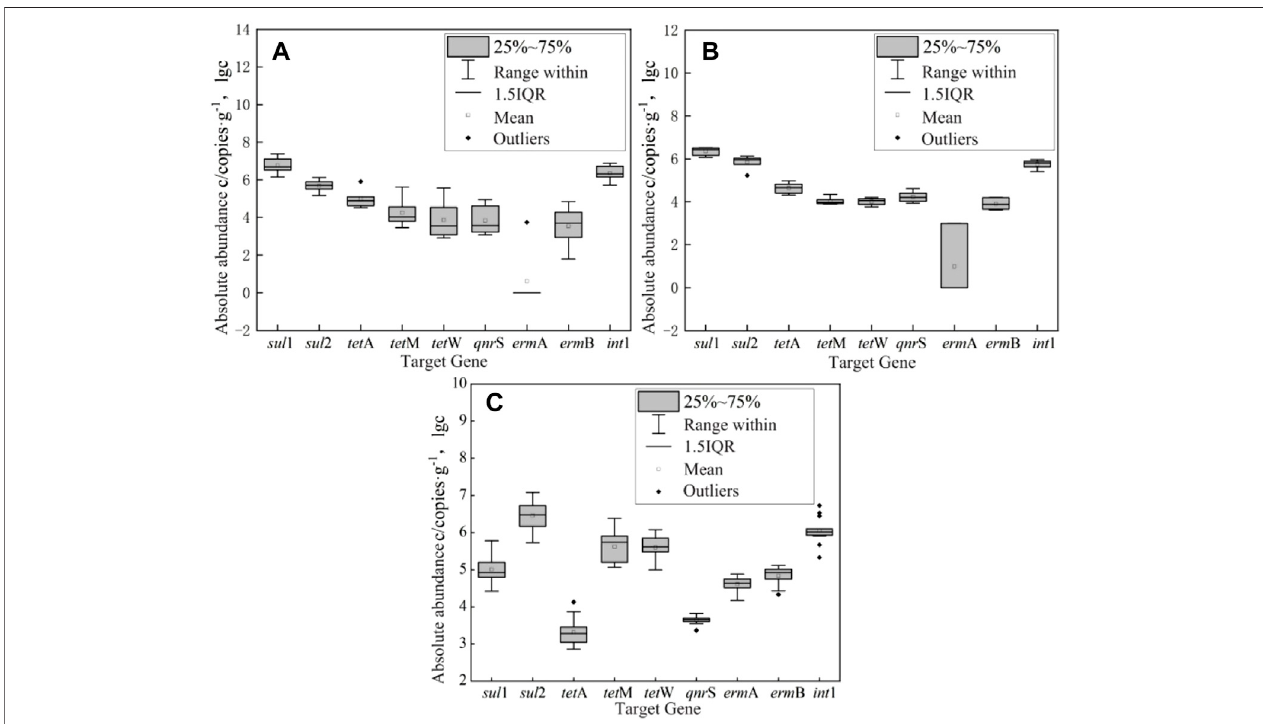
FIGURE 7 | Box-plot of absolute abundance of ARGs and integron int1 in sediments of East Dongting Lake in spring (A) , summer (B) , and fall (C) .